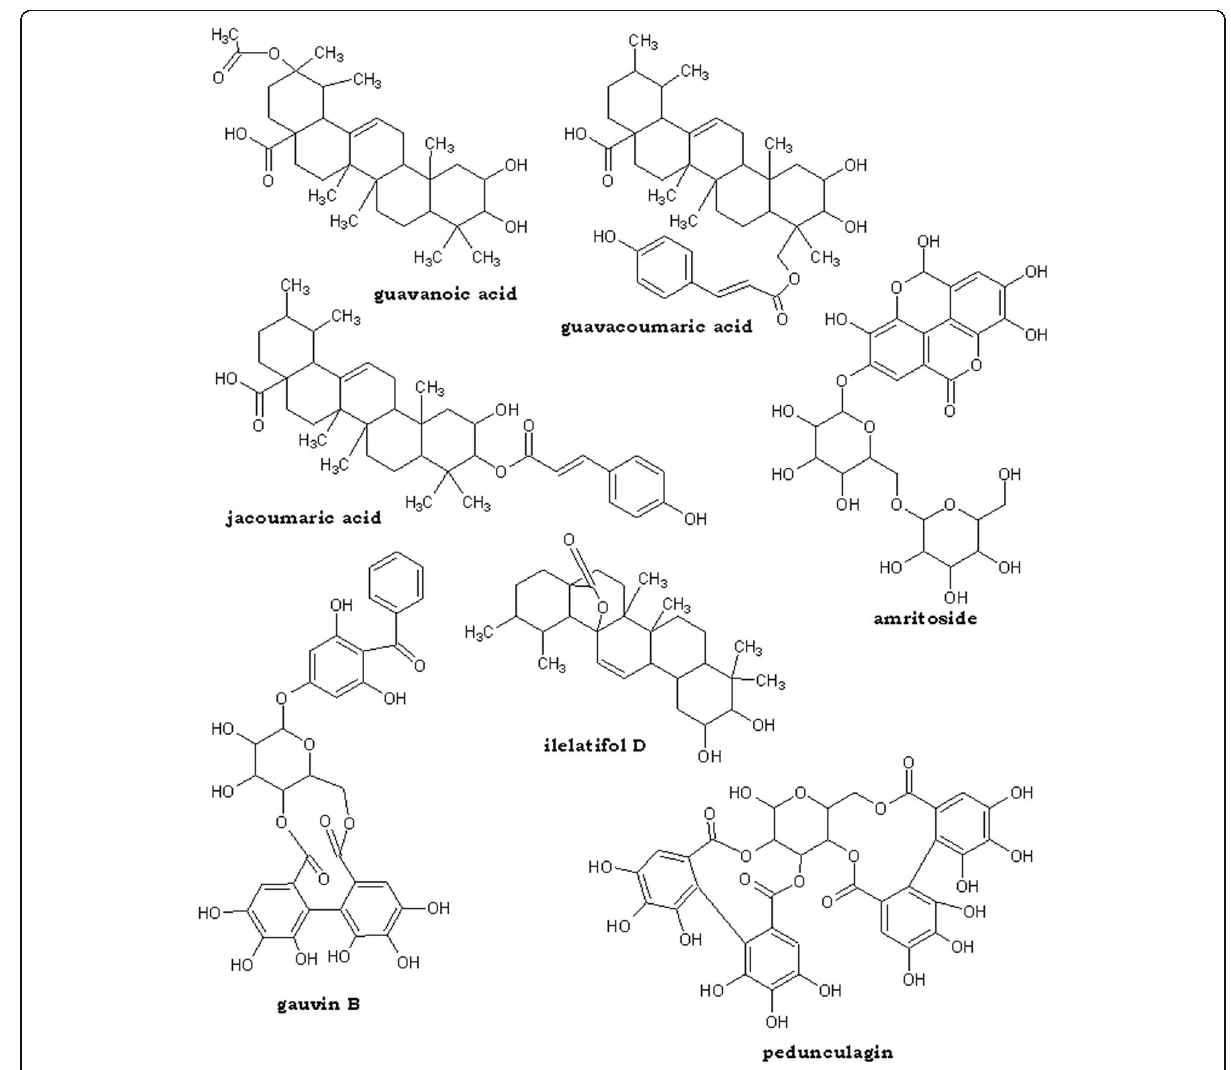
Fig. 3 Phytochemical constituents present in P.guajava